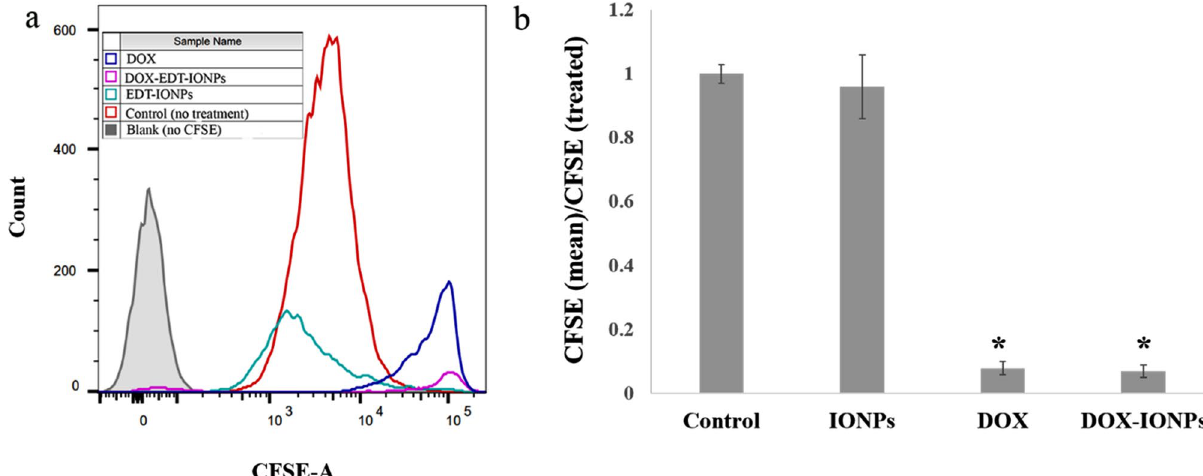
Figure 7. Flow cytometer analysis for cell proliferation assay of carboxyfluorescein succinimidyl ester (CFSE)- labelled U251 upon treatment with EDT-IONPs, DOX and DOX-EDT-IONPs. ( a ) CFSE flow cytometry graph, and ( b ) the relative cell proliferation inhibition calculated by (mean CFSE control/mean CFSE treated). *Shows a significant difference compared to the control group at p < 0.05. IONPs and DOX-IONPs represent for EDT- IONPs and DOX-EDT-IONPs.